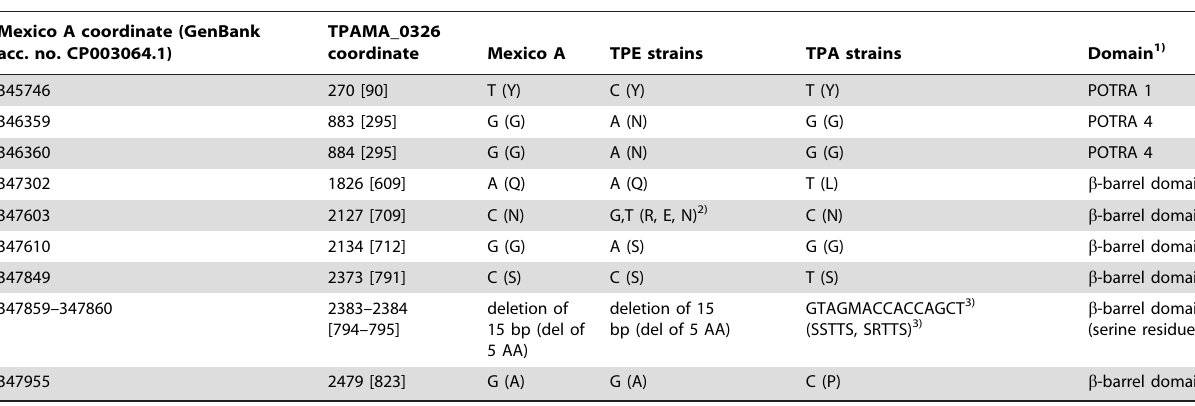
Table 1. A list of changes found in the TPAMA_0326 locus.